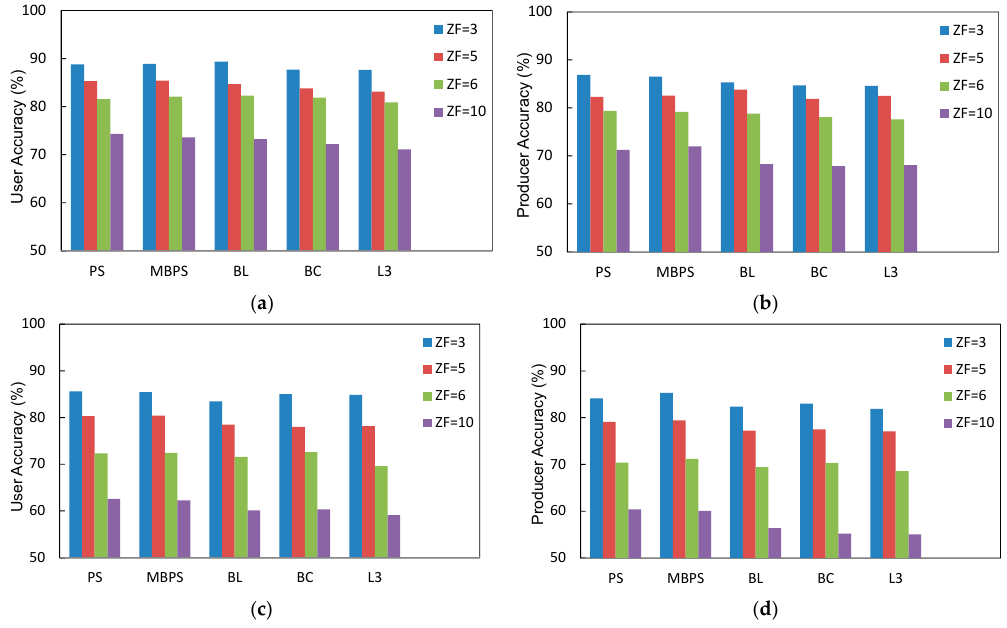
Figure 23. User and producer accuracies of SRM algorithms using real water fractions of: ( a , b ) the SPU algorithm, and ( c , d ) the OBA-NDWI algorithm across a range of ZF for Noce River; (PS: pixel swapping, MBPS: modified binary PS, BL: bilinear, BC: bicubic, L3: lanczos3).